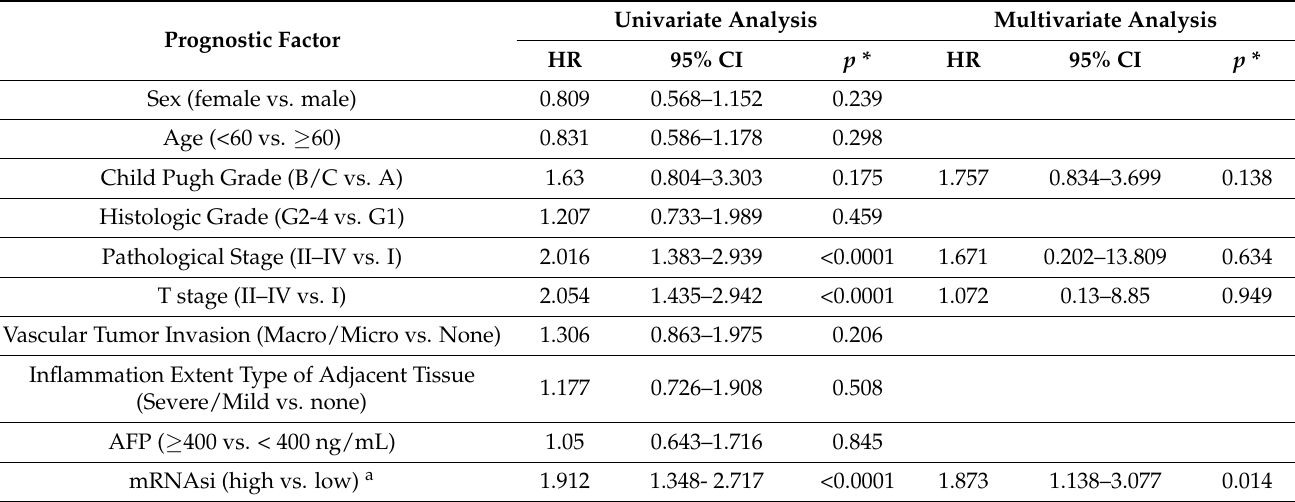
Table 2. Prognostic factors of overall survival in the TCGA-LIHC